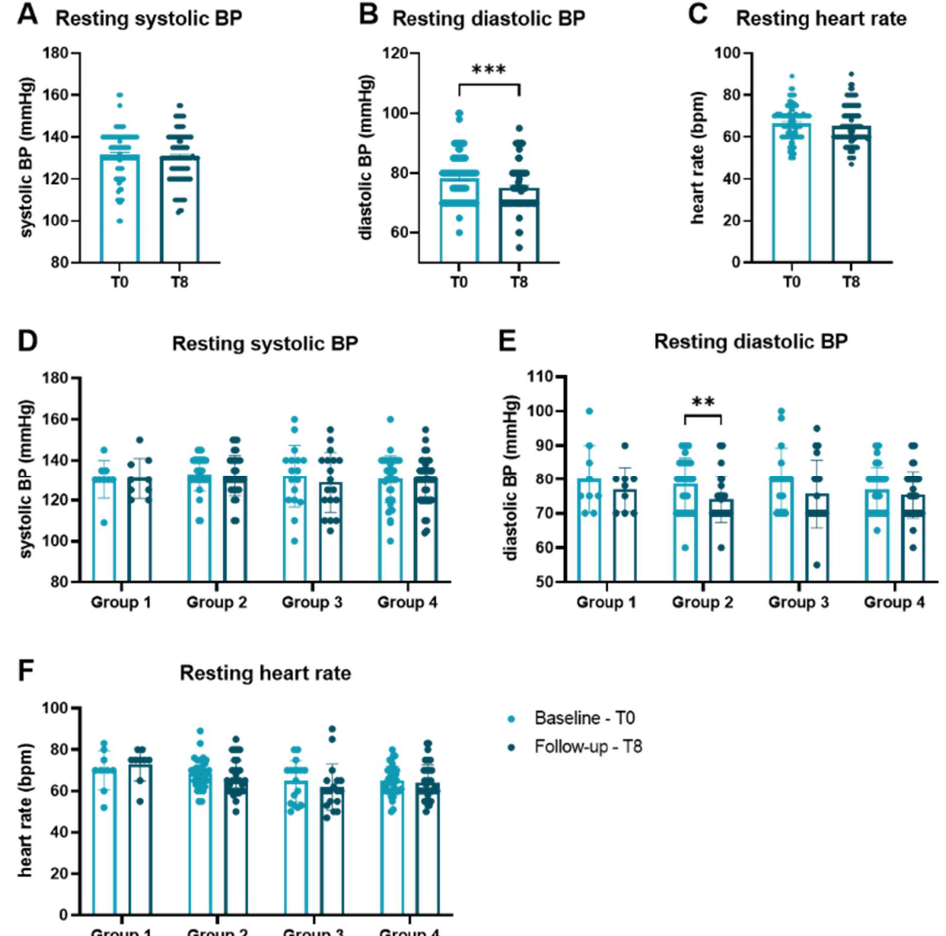
Figure 1. Vital parameters at rest at baseline and follow-up. Comparison of ( A ) systolic BP, ( B ) diastolic BP, and ( C ) heart rate measured at rest between baseline and 8 months. ( D ) Systolic BP, ( E ) diastolic BP, and ( F ) heart rate are presented according to performance categories. Groups were compared by Wilcoxon matched-pairs signed rank tests. Data are presented as scatter dot plots with mean ± SEM. ** p < 0.01, *** p < 0.001. BP blood pressure, bpm beats per minute, SEM standard error of the Table 1. Cardiovascular risk factor profile, anthropometric, and laboratory data at baseline of all four groups. Data are presented as mean ± SD.